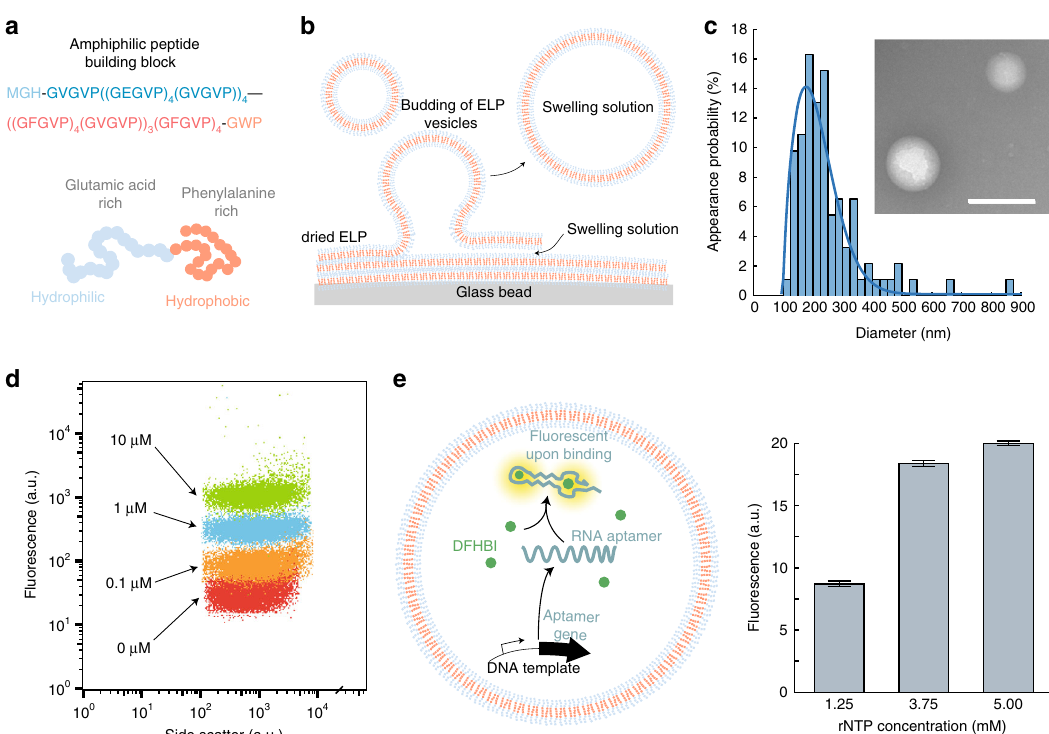
Fig. 1 ELP vesicle formation and transcription. a The peptide building block is an amphiphilic ELP with a hydrophilic glutamic acid-rich domain and a hydrophobic phenylalanine-rich domain. b For vesicle formation dried ELPs are rehydrated from glass beads. c Size distribution of the produced vesicles obtained from TEM measurements with diameter of 176 nm. The data are described using a Weibull probability distribution (solid line). The inset shows a typical TEM image. Scale bar: 200 nm. d Co-localization of fl uorescently labeled DNA (with indicated concentrations) into the vesicles measured by fl ow cytometry. e Left: Illustration of the transcription of an RNA aptamer inside of an ELP vesicle. The aptamer binds to DFHBI, which then fl uoresces. Right: Plateau value means of the DFHBI fl uorescence after 50 min of transcription for various rNTP concentrations. The given error bars indicate the sample standard deviation of the measured plateau